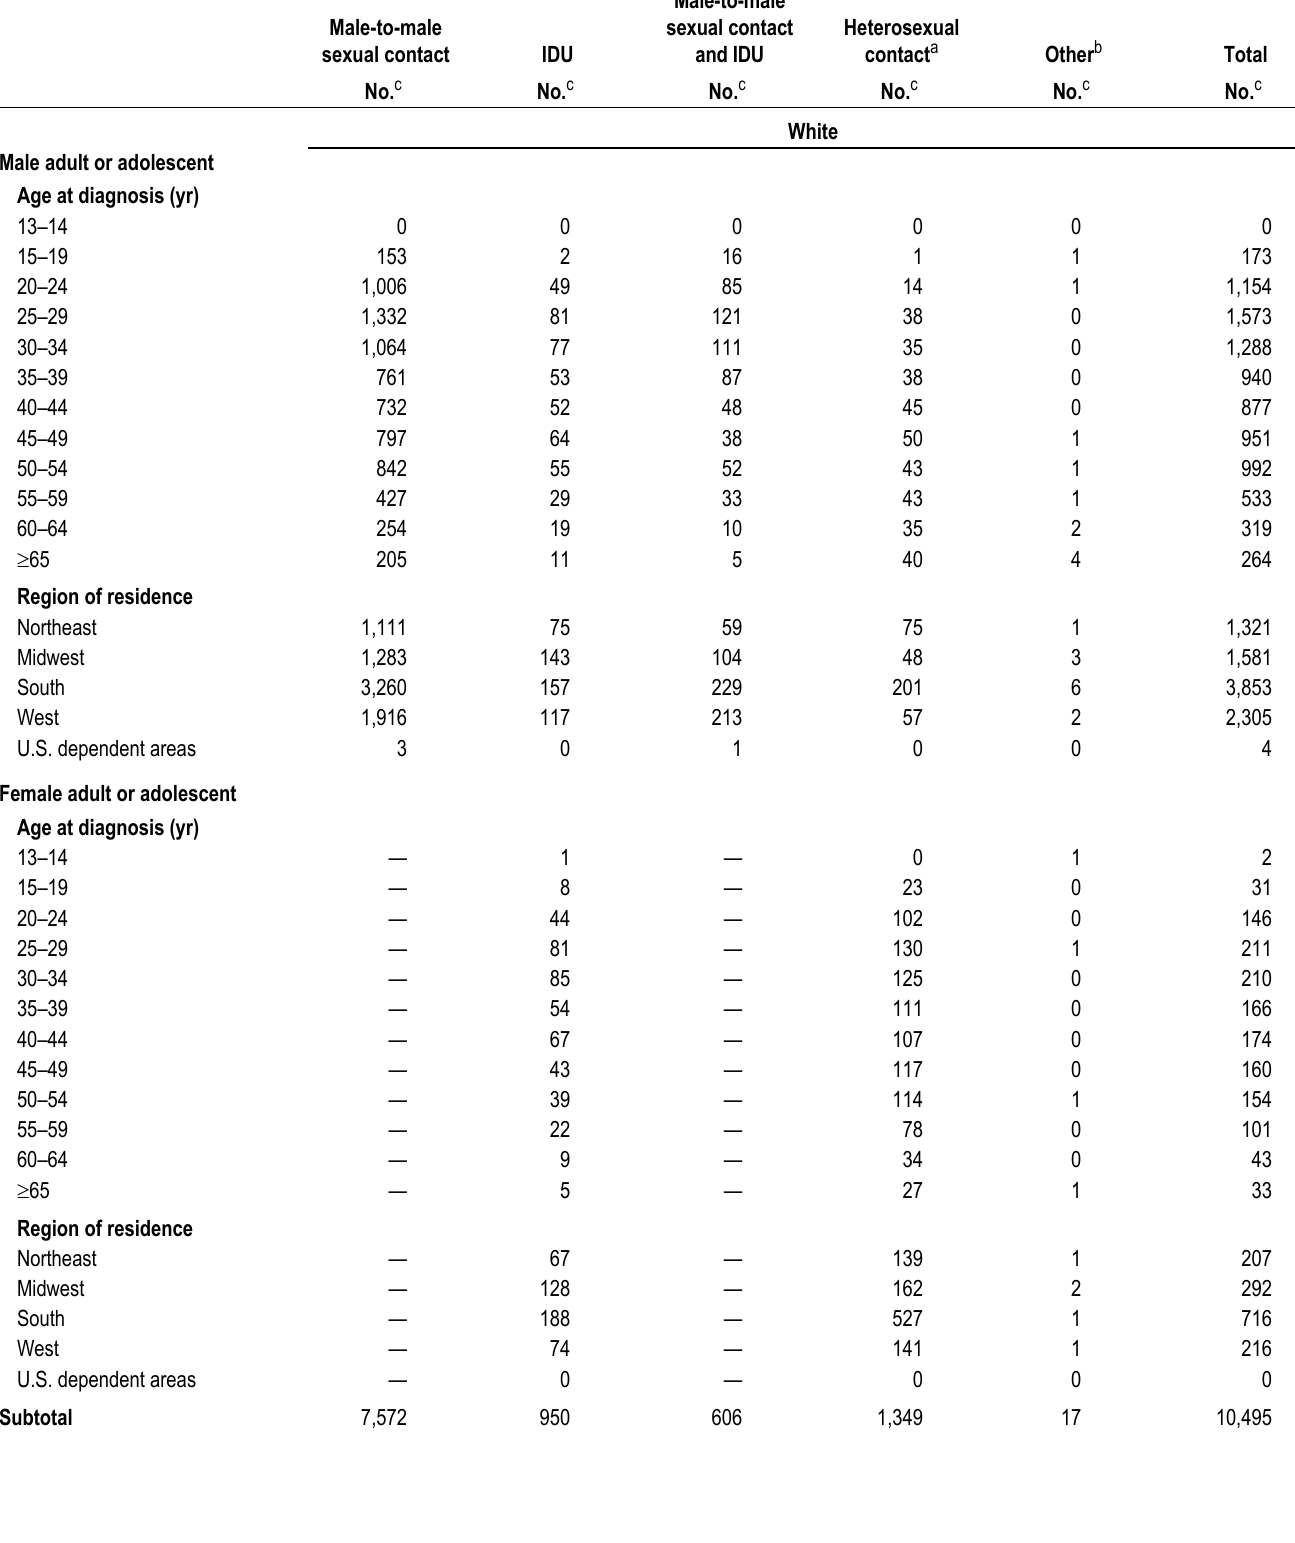
Table 5b. Diagnoses of HIV infection, by transmission category, race/ethnicity, and selected characteristics, 2015—United States and 6 dependent areas